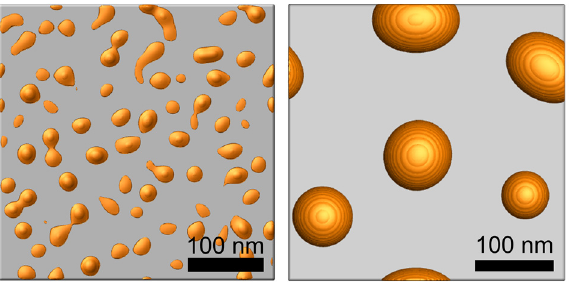
Figure 2. Simulation result of an island-shaped structure y in thermal dewetting with 5 nm (left) and 10 nm (right) thick Au deposition on a flat substrate.